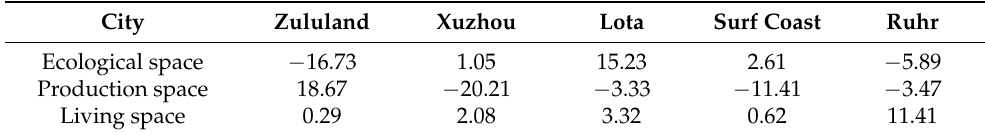
Table 4. Variation of LPI of five cities from 1975 to 2020. Unit: Percentage. City Zululand Xuzhou Lota Surf Coast Ruhr Ecological